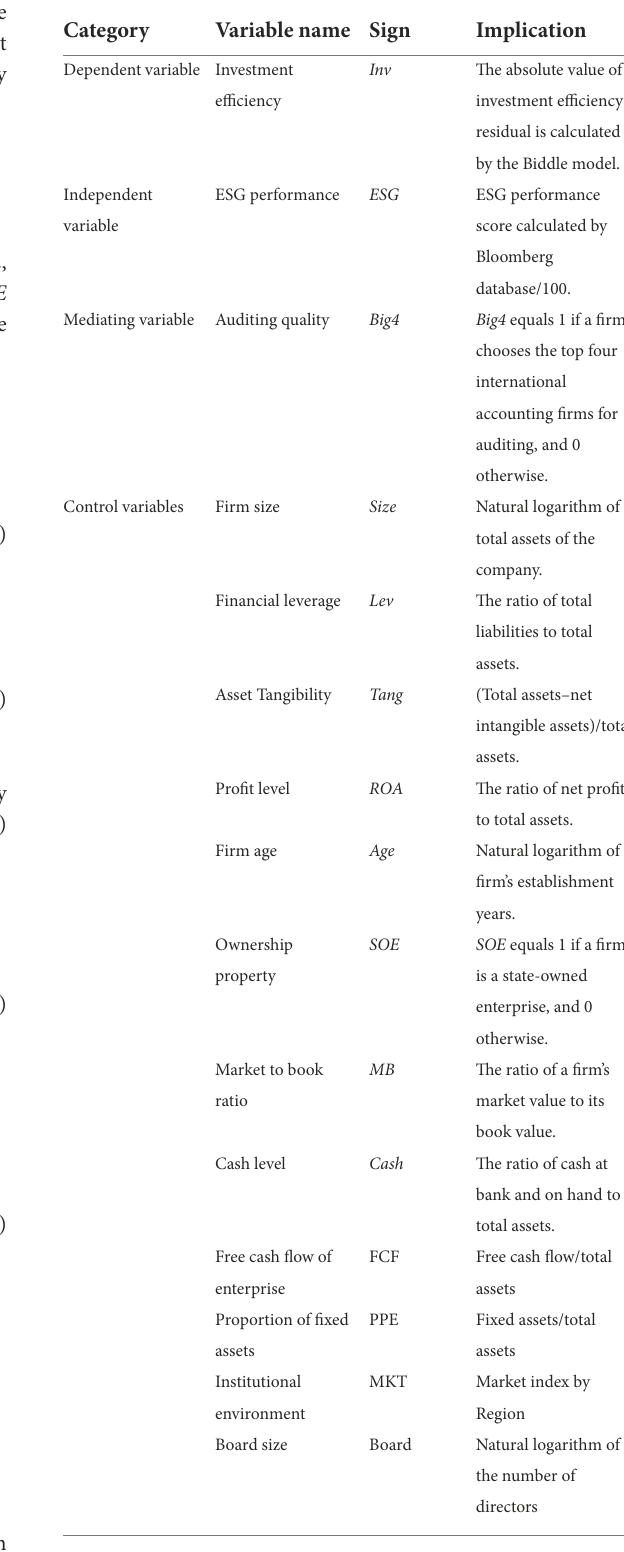
TABLE 1 Definitions of